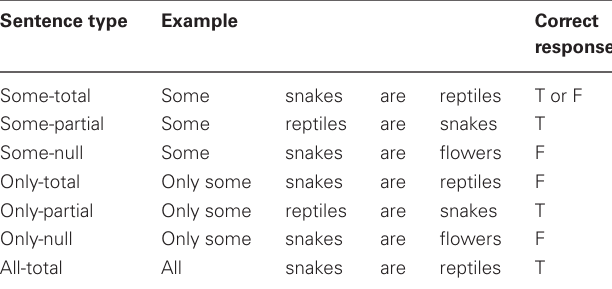
Table 3 | Examples stimuli for the linguistic task. Sentence